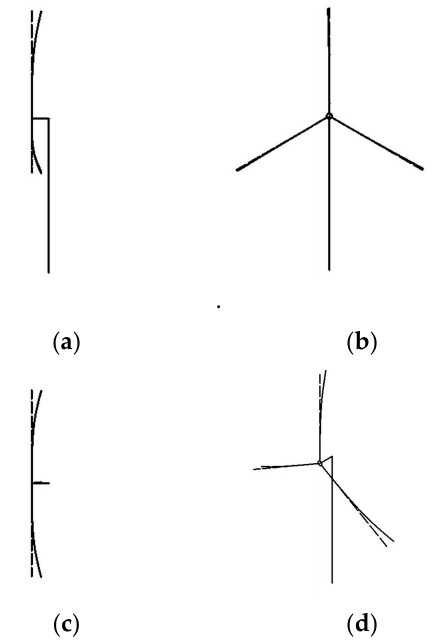
Figure 21. The abbreviated sketches of blade deflection: ( a ) front side view; ( b ) left side view; ( c ) vertical side view; and ( d ) southwest isometric side view.